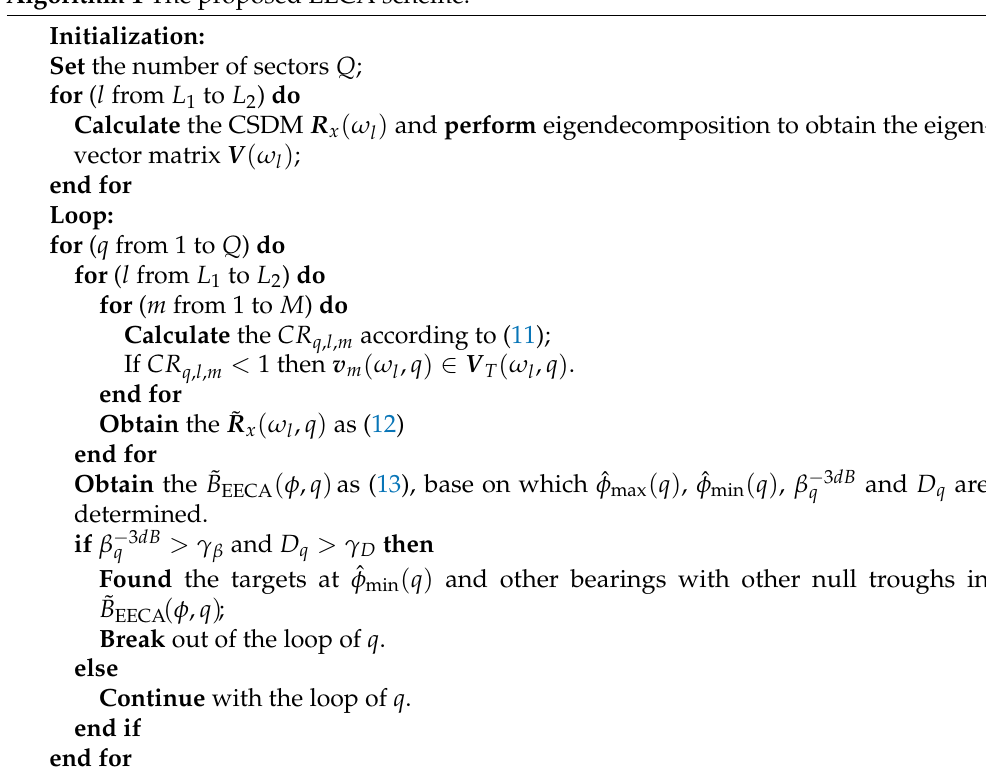
Algorithm 1 The proposed EECA